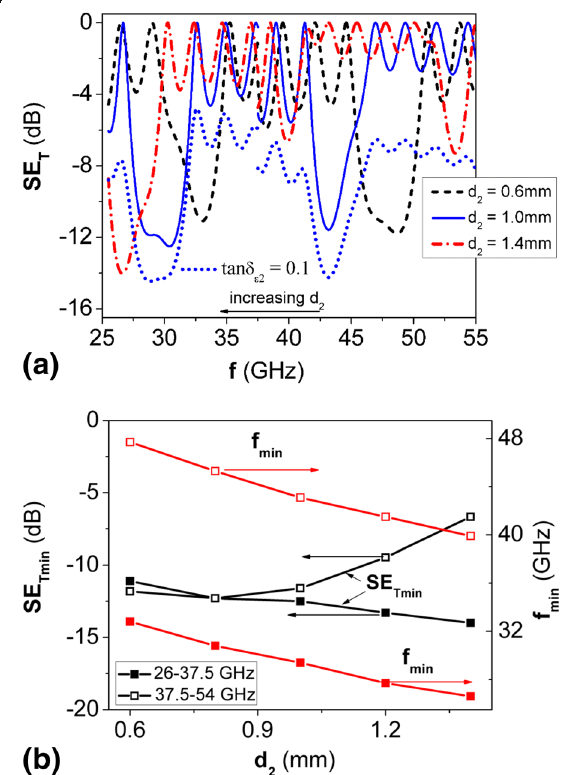
Fig. 3 Calculated EMR transmission spectra ( a ) for 1D PS (LH) 5 at various values of thickness d 2 of H-layers and dependencies of position and depth of PBG on thickness d 2 of H-layers ( b ); ε ′ r tan δ ε 2 = 0.003. Short-dotted curve on Fig. 3a corresponds to case, when d 2 =1 mm and tan δ ε 2 =0.1